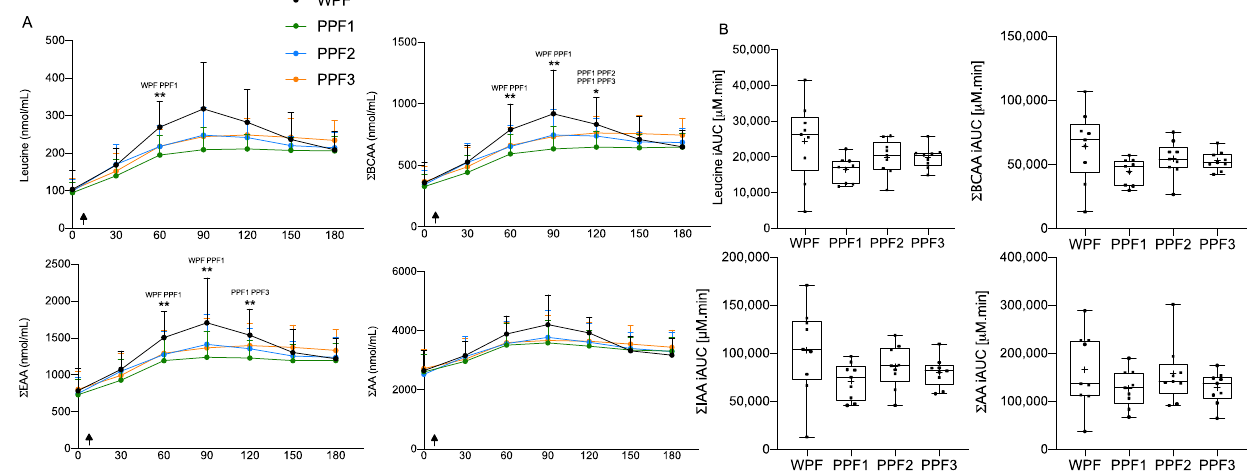
Figure 3. Plasma Σ AA, Σ IAA, Σ BCAA and leucine concentration ( A ) over time (min) and ( B ) their iAUC, in response to a test meal containing WPF or PPF 1, 2, or 3. Values are mean ± SD ( n = 9). Arrows indicate the ingestion of the meal. Concentration over time data were assessed by 2-way repeated measurements (time × treatment) ANOVA, and iAUC was compared with a 1-way repeated measures (treatment) ANOVA. Significant at p < 0.05 (*) or p < 0.01 (**). The products’ names above the asterisk indicate the treatments in which postprandial AA concentrations significantly differ at that time. BCAA, branched-chain amino acids; IAA, indispensable amino acids; iAUC, incremental area under the curve; PPF, plant protein fibre; WPF, whey protein fibre.